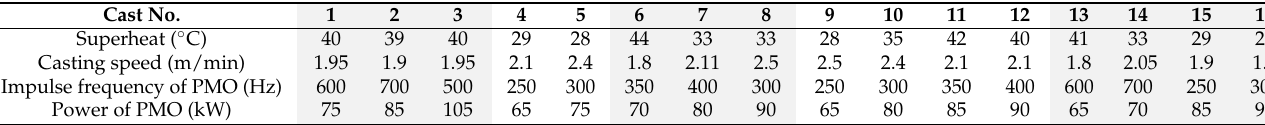
Table 3. Experimental parameters.